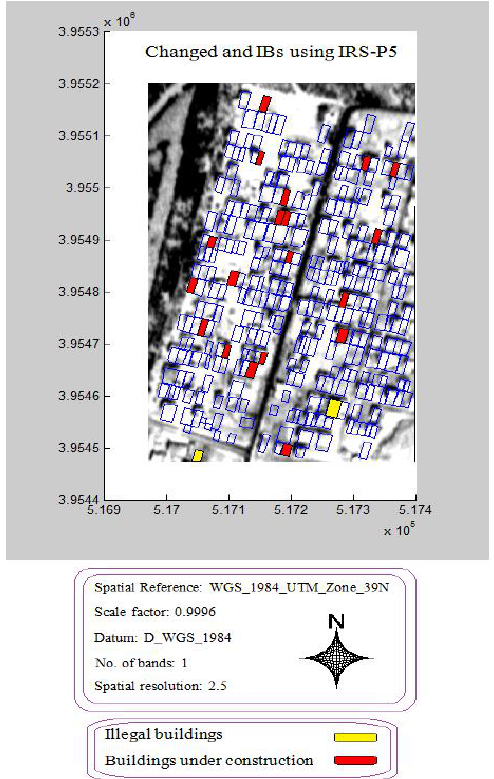
Figure 10. The detected under construction buildings and IBs using IRS-P5 satellite images